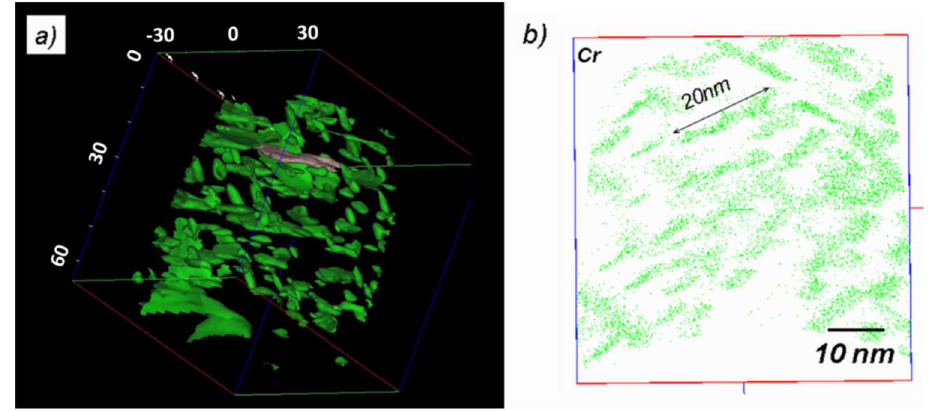
Figure 5. APT reconstruction in the nitrided layer containing CrN: ( a ) isoconcentration Cr + N > 40 at.%, showing the morphology and distribution of CrN platelets; ( b ) atom map showing the location of individual Cr atoms. For clarity, the represented volume is restricted to a 2 nm thick slice. Concentration profiles are plotted by moving sampling sub-volumes along a given direction.